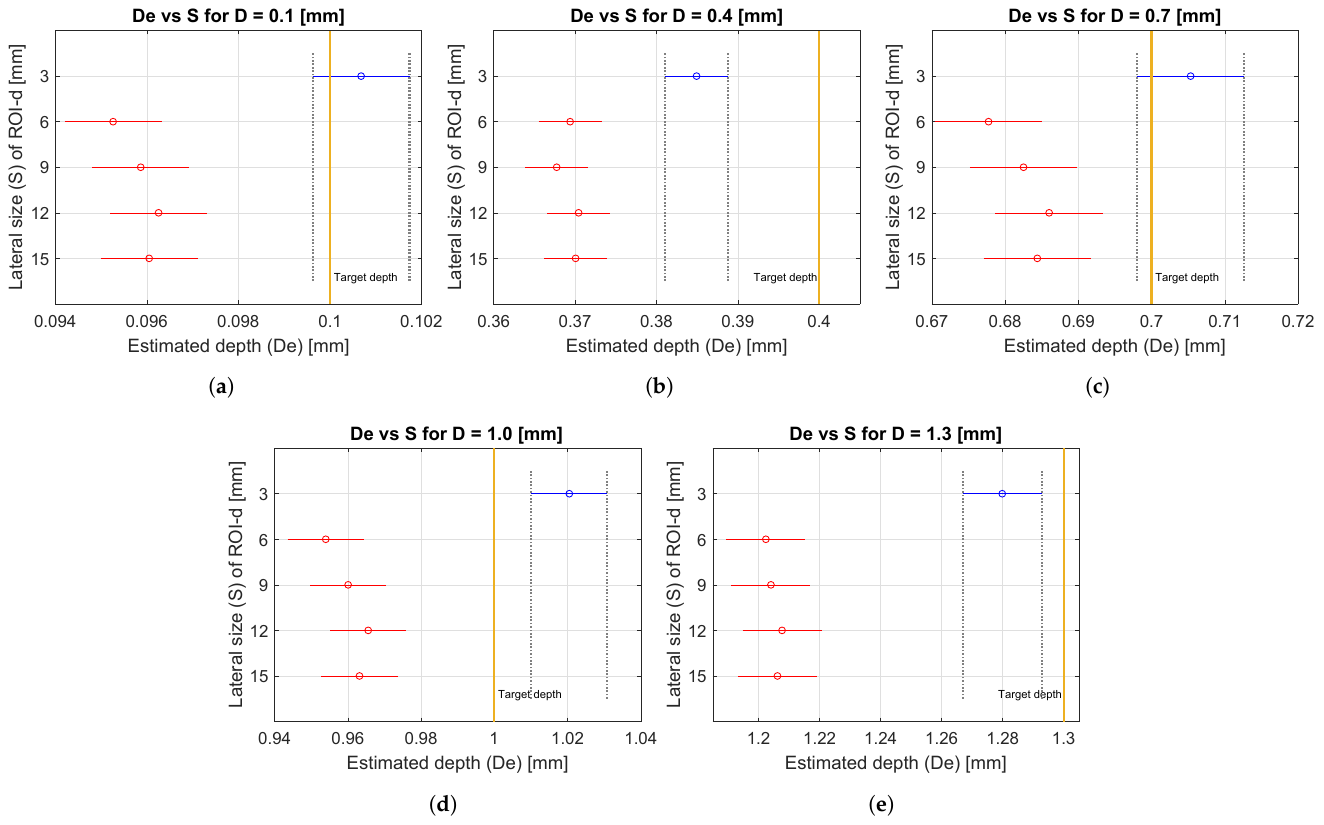
Figure 5. Analysis of variance (ANOVA) of estimated depth ( D e ) and lateral size ( S ) of defects varying the actual depth ( D ) of defects. Test performed on simulated sequence maxigrams of CFRP samples. ( a ) D = 0.1 mm, ( b ) D = 0.4 mm, ( c ) D = 0.7 mm, ( d ) D = 1.0 mm and ( e ) D = 1.3